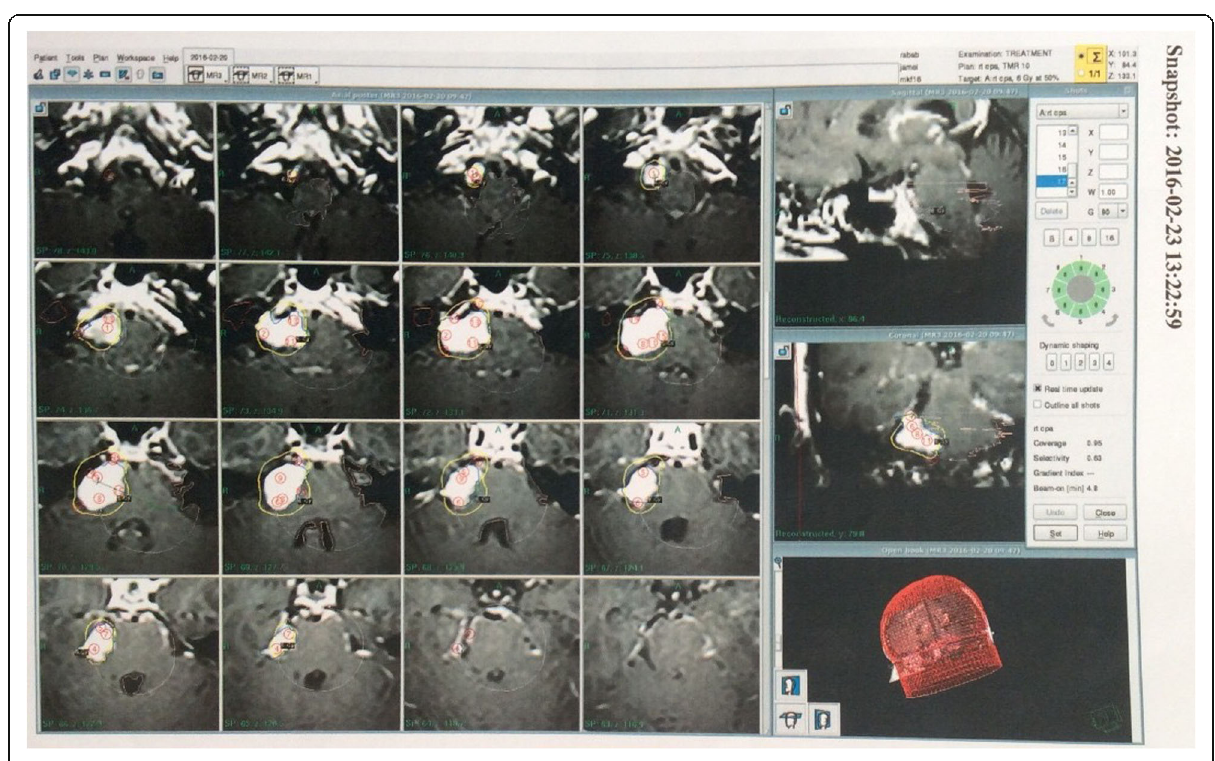
Fig. 1 Surgiplan platform for VS tumor